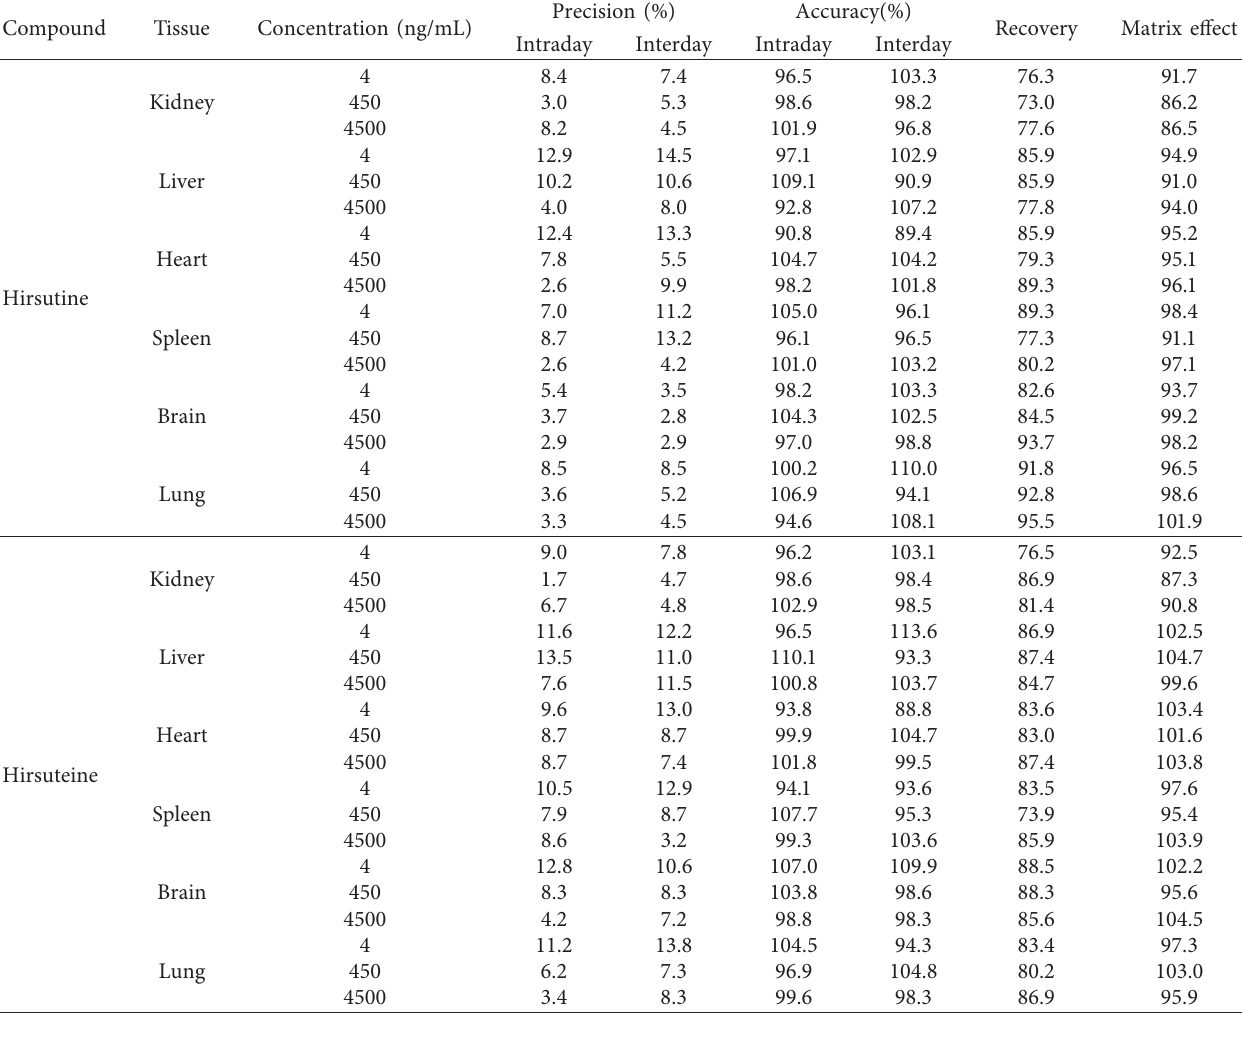
Table 2: Precision, accuracy, matrix effect, and recovery of hirsutine and hirsuteine in mouse tissue ( n � 6). Precision (%) Compound Tissue Concentration (ng/mL)